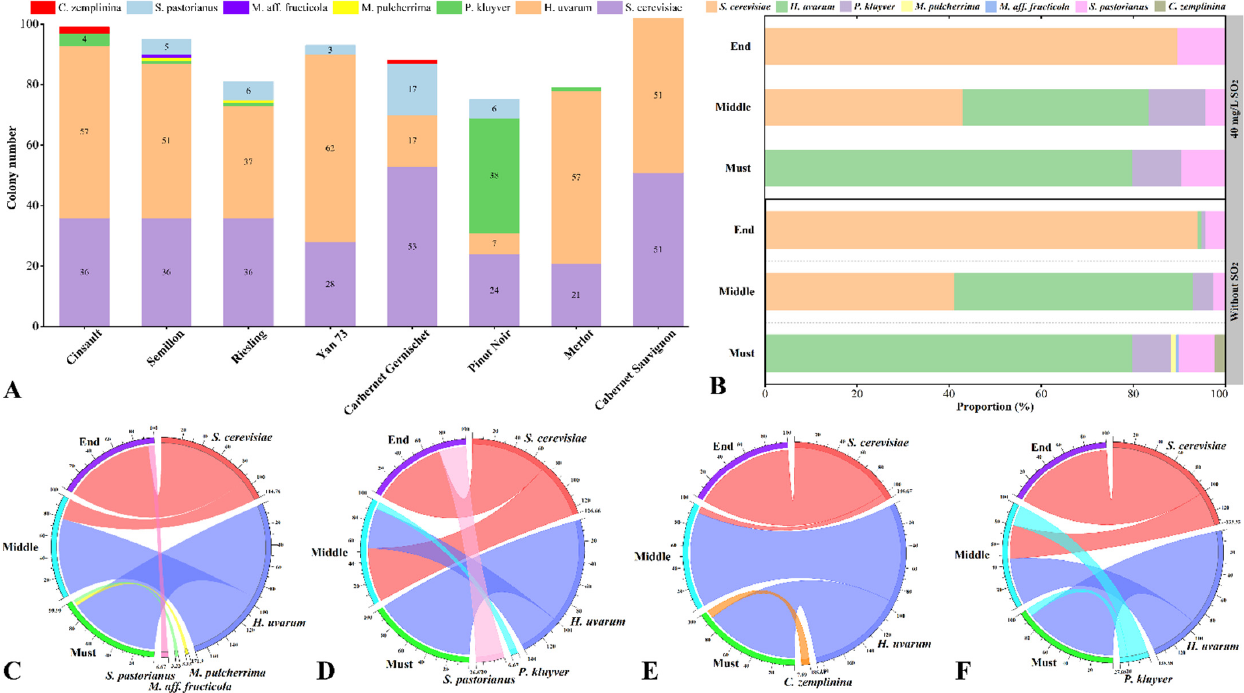
Figure 2. The distribution and dynamics of yeast during spontaneous fermentation. ( A ): Colony numbers of yeast species in spontaneous fermentations with different grape cultivars. ( B ): Relative abundance of yeast species during spontaneous fermentation with/without SO 2 addition. The relative abundance of yeast species during SO 2 -free spontaneous fermentation with Semillon ( C ) and Cinsault ( E ). The relative abundance of yeast species during spontaneous fermentation with Semillon ( D ), Cinsault ( F ) treated with SO 2 . Must, before fermentation; Middle, the middle stage of fermentation; End, the end stage of fermentation.